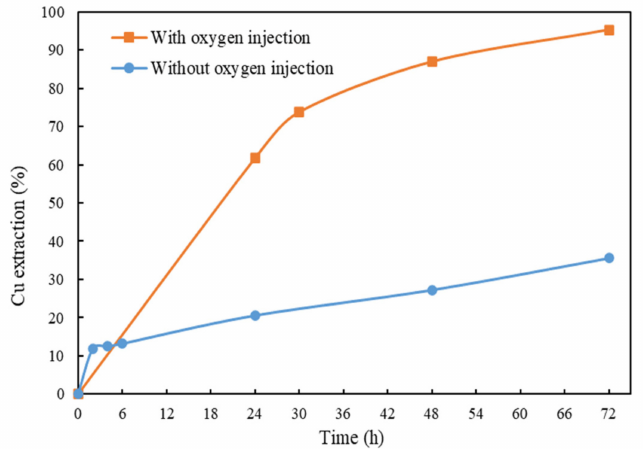
Figure 8. Cu extraction after 72 h of leaching at 10% solid/liquid ratio. Other conditions: Gly:Cu = 4:1, pH = 10.5, room temperature and ceramic beads: solid =